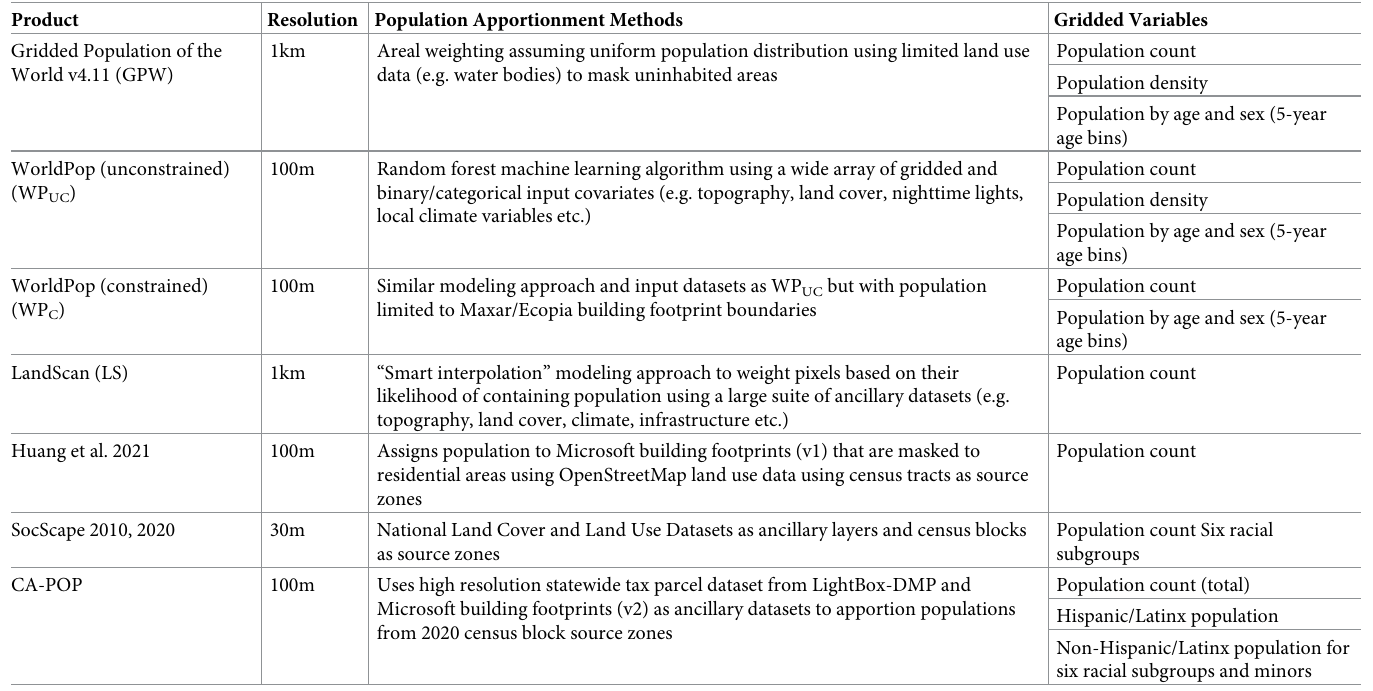
Table 2. Description of gridded datasets assessed. GPW, WPC, WPUC and LS datasets all currently use 2010 census blocks as their source zones, which will likely be updated to 2020 census blocks in subsequent grids. Product Resolution Population Apportionment